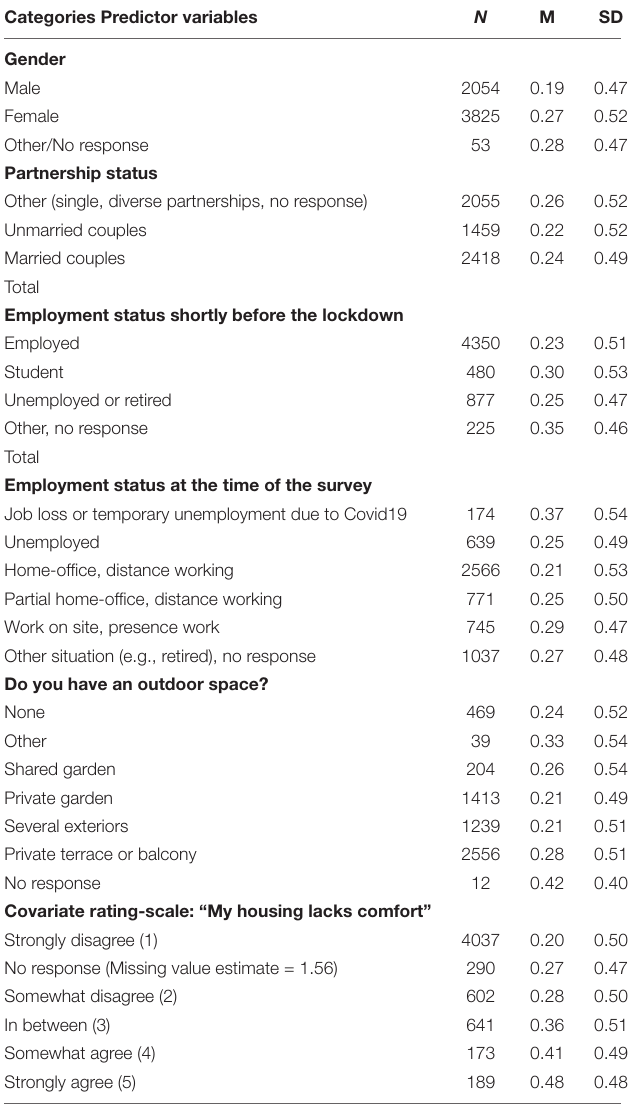
TABLE 6 | Mean values of changes in subjective psychological strain according to predictor